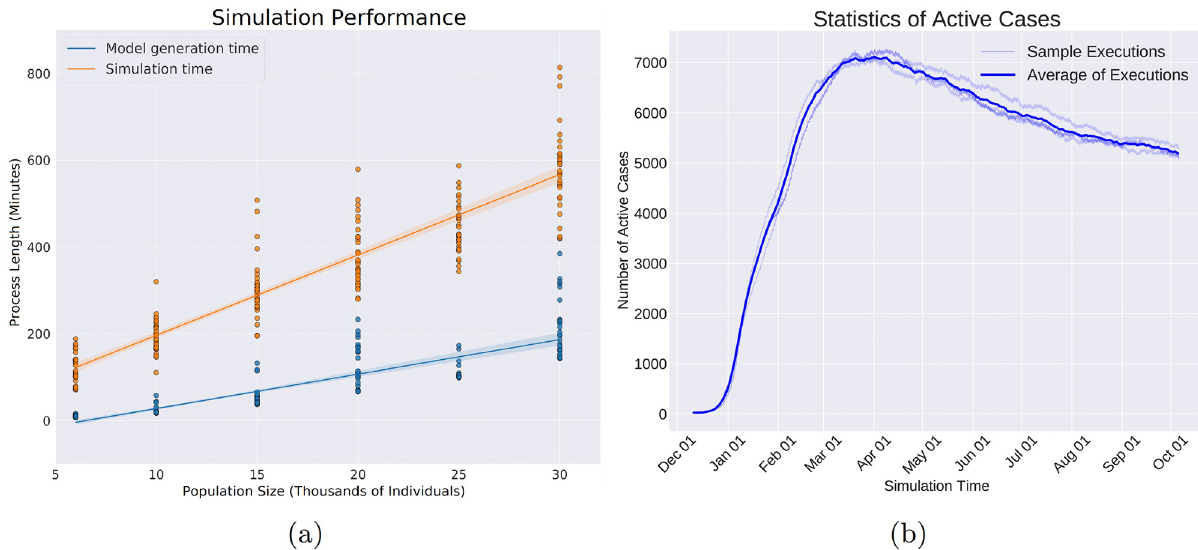
Fig 8. a) The time it takes to generate the population and to simulate the propagation of the disease for 48 hours is plotted for six cities with population sizes from 6k to 30k. The clock (virus spread period) is 60 minutes in this experiment. The horizontal axis represents the population size, and the vertical axis represents the total process time. The experiment for every size of the population is repeated multiple times (each vertically aligned dot corresponds to an experiment) to achieve confidence, and the straight line indicates the trend. b) The number of active cases versus time is shown for a sample city with a population size of 20k. To emphasize the probabilistic nature of Pyfectious, the same experiment is repeated multiple times, and the effect of this randomness is seen by observing slightly different trajectories. The blue curve is the moving average (window size of 2) of all executions to show the